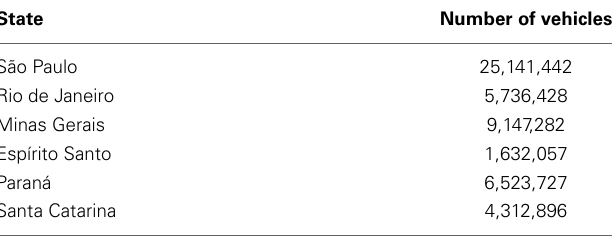
Table 4 | Total number of vehicles in each of the states within the modeling domain.